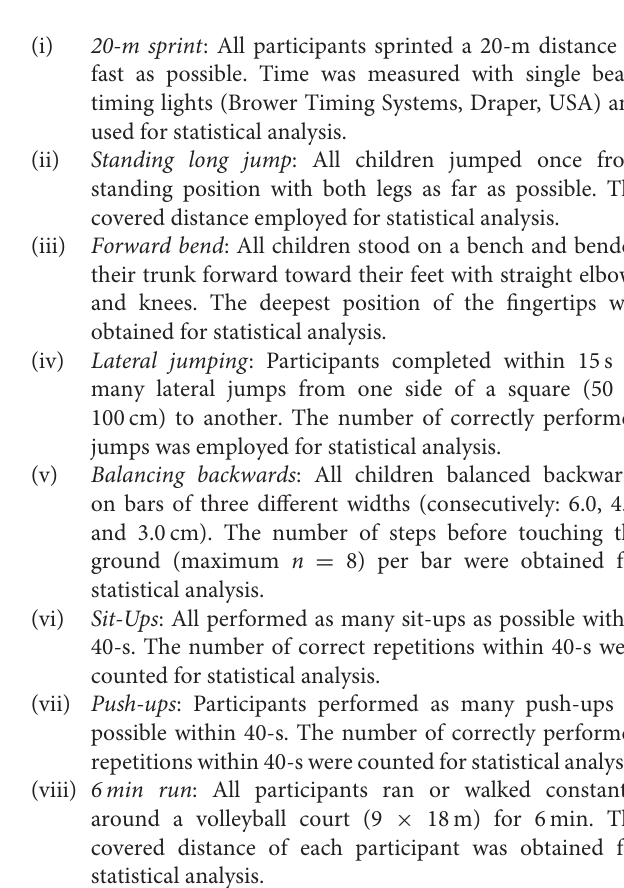
counted for statistical analysis.